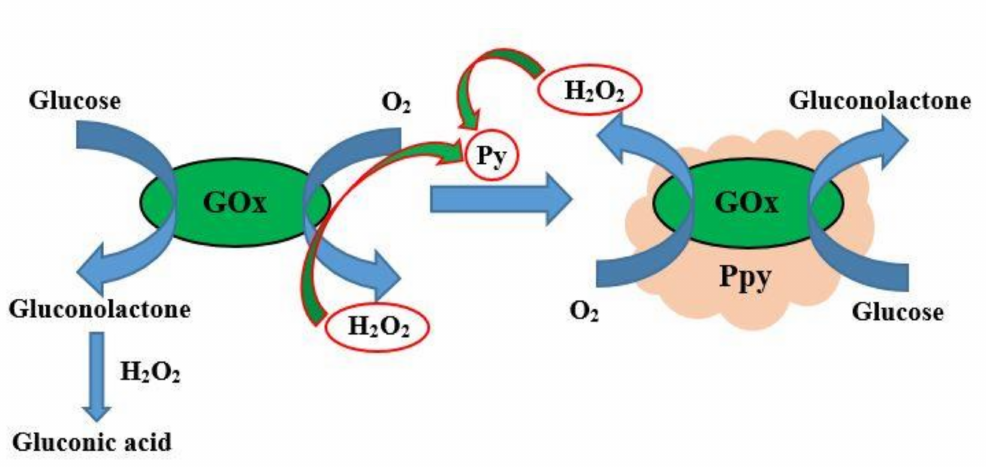
Figure 1. Chemical synthesis of polypyrrole, which was performed by glucose oxidase (GOx) assisted polymerization, where H 2 O 2 is formed by GOx and acts as an initiator of the polymerization reaction. Figure adapted from